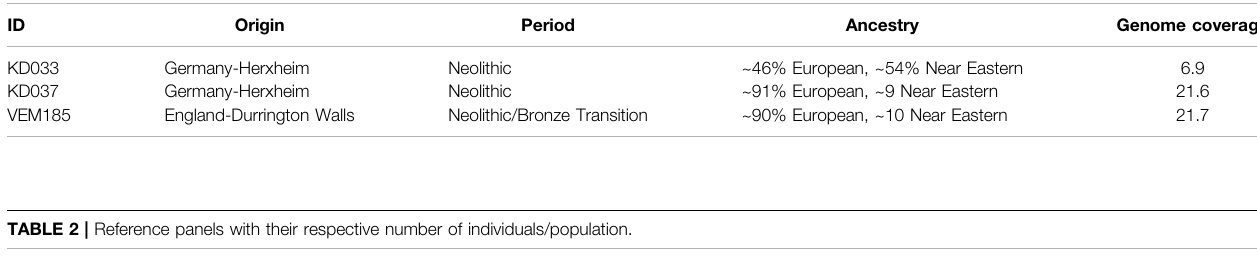
TABLE 1 | Sample information. ID, origin, period and ancestry taken from Frantz et al. (2019).